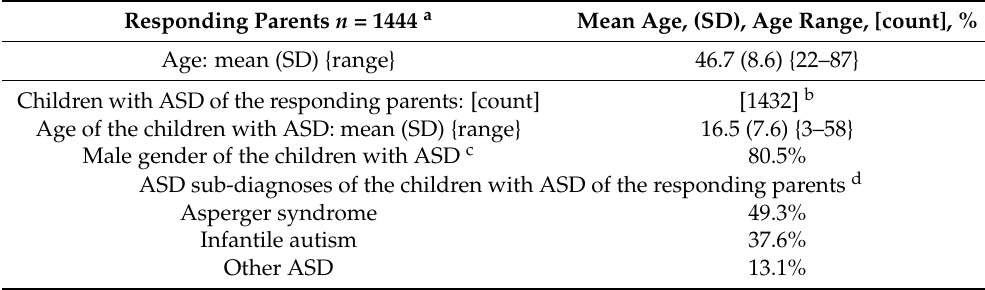
Table 1. Demographics: Responding parents and their children with ASD.